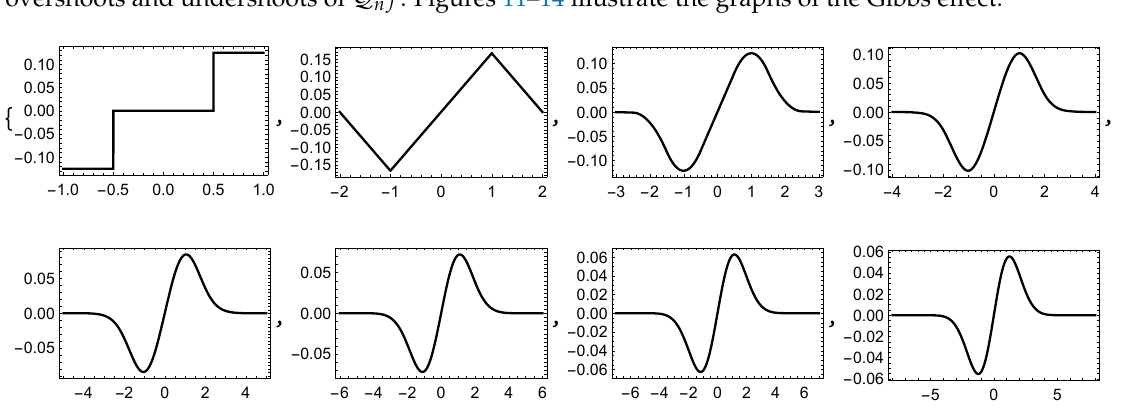
Figure 9. Graphs of Q f ( x ) by the B -splines of order 1 through 8,